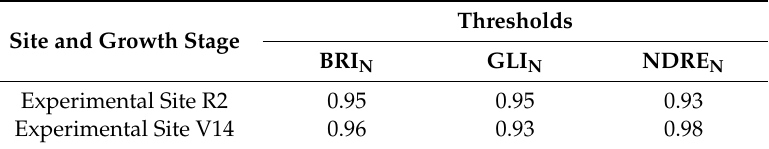
Table 4. Thresholds for the normalized blue reflectance index (BRI N ), green leaf index (GLI N ), and normalized di ff erence red-edge (NDRE N ) values generated using univariate Gaussian mixture modeling. Thresholds were used to indicate “high” and “low” relative groupings for each index at either the 14th leaf stage (V14) or blister (R2) stage of